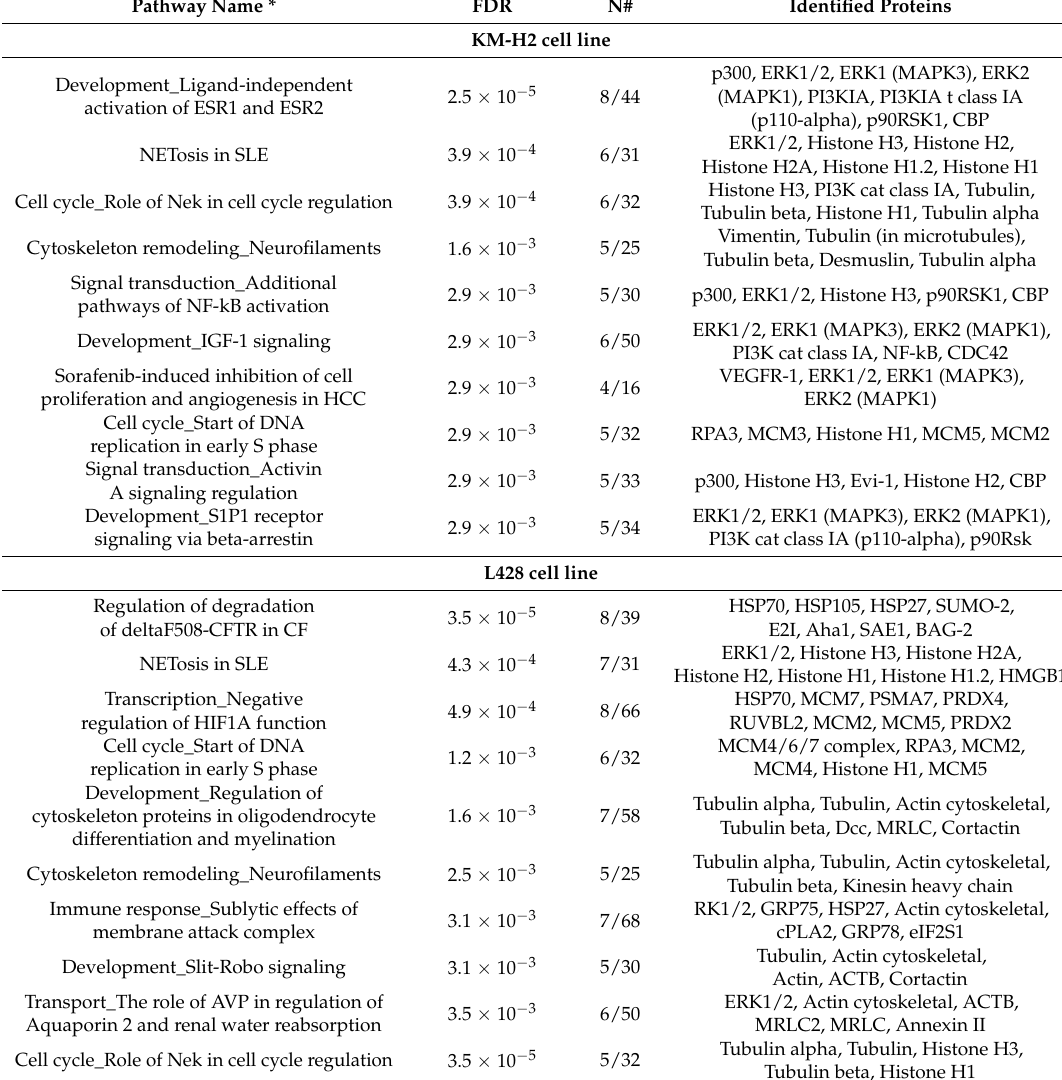
Table 1. Representative pathways modulated by celastrol in KM-H2 and L428 cell lines and differentially expressed proteins present in these major